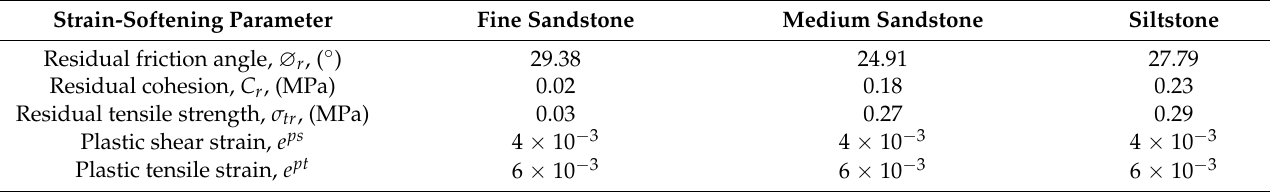
Table 2. Strain-softening property values of the rock masses.